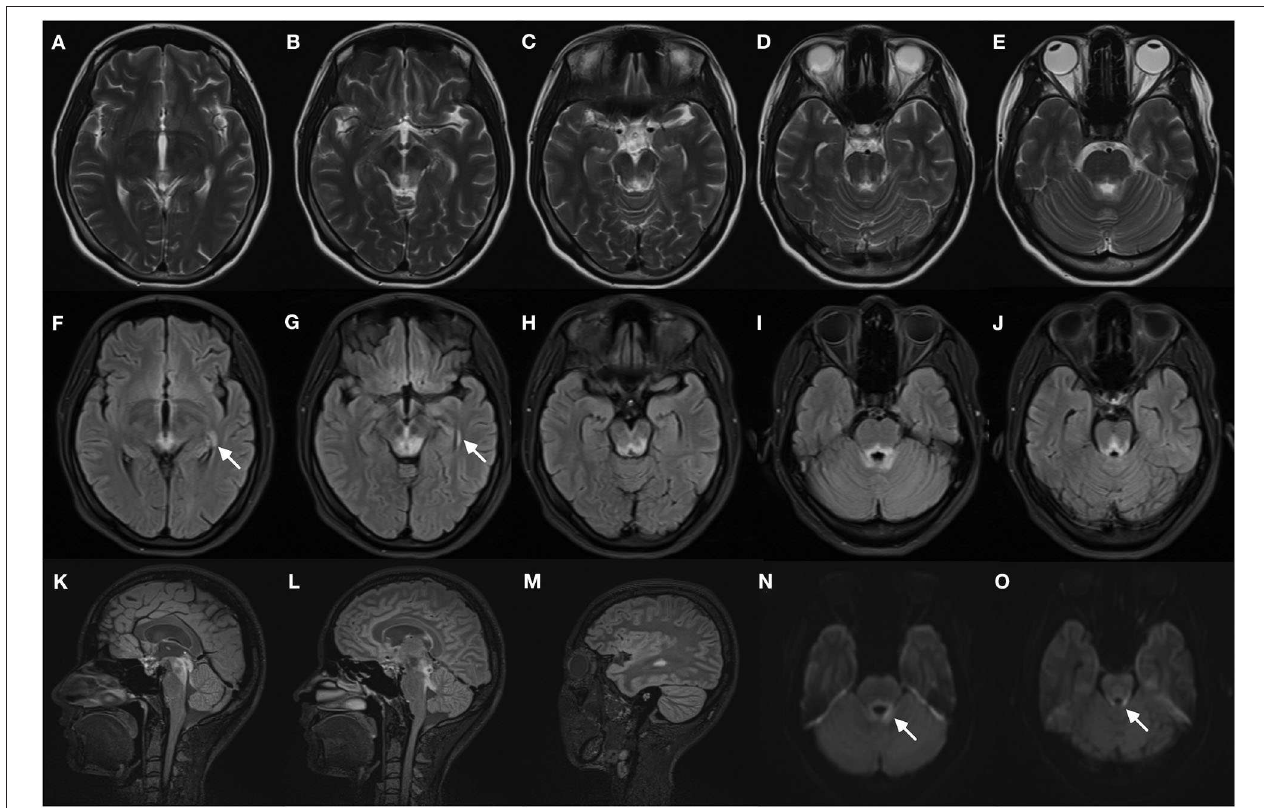
FIGURE 1 | Brain magnetic resonance images of the patient. T2-weighted images (A–E) demonstrate bilateral symmetrical hyperintense lesions in periaqueductal regions and around the fourth ventricle, which include superior colliculus (A) , ventral tegmental area (B) , inferior colliculus (C) , and superior cerebellar peduncle (D,E) . The abnormal regions revealed more obvious hyperintensity signal on corresponding FLAIR images (F–J) , increased signal in the lateral ventricles was found ( F,G , arrows). The FLAIR sagittal slice showed apparent hyperintense signal in the periaqueductal gray region (K) and surrounding the fourth ventricle (L) , and lesions in the lateral ventricles (M) . DWI images also manifest restricted water diffusion adjacent to the fourth ventricle ( N,O ,